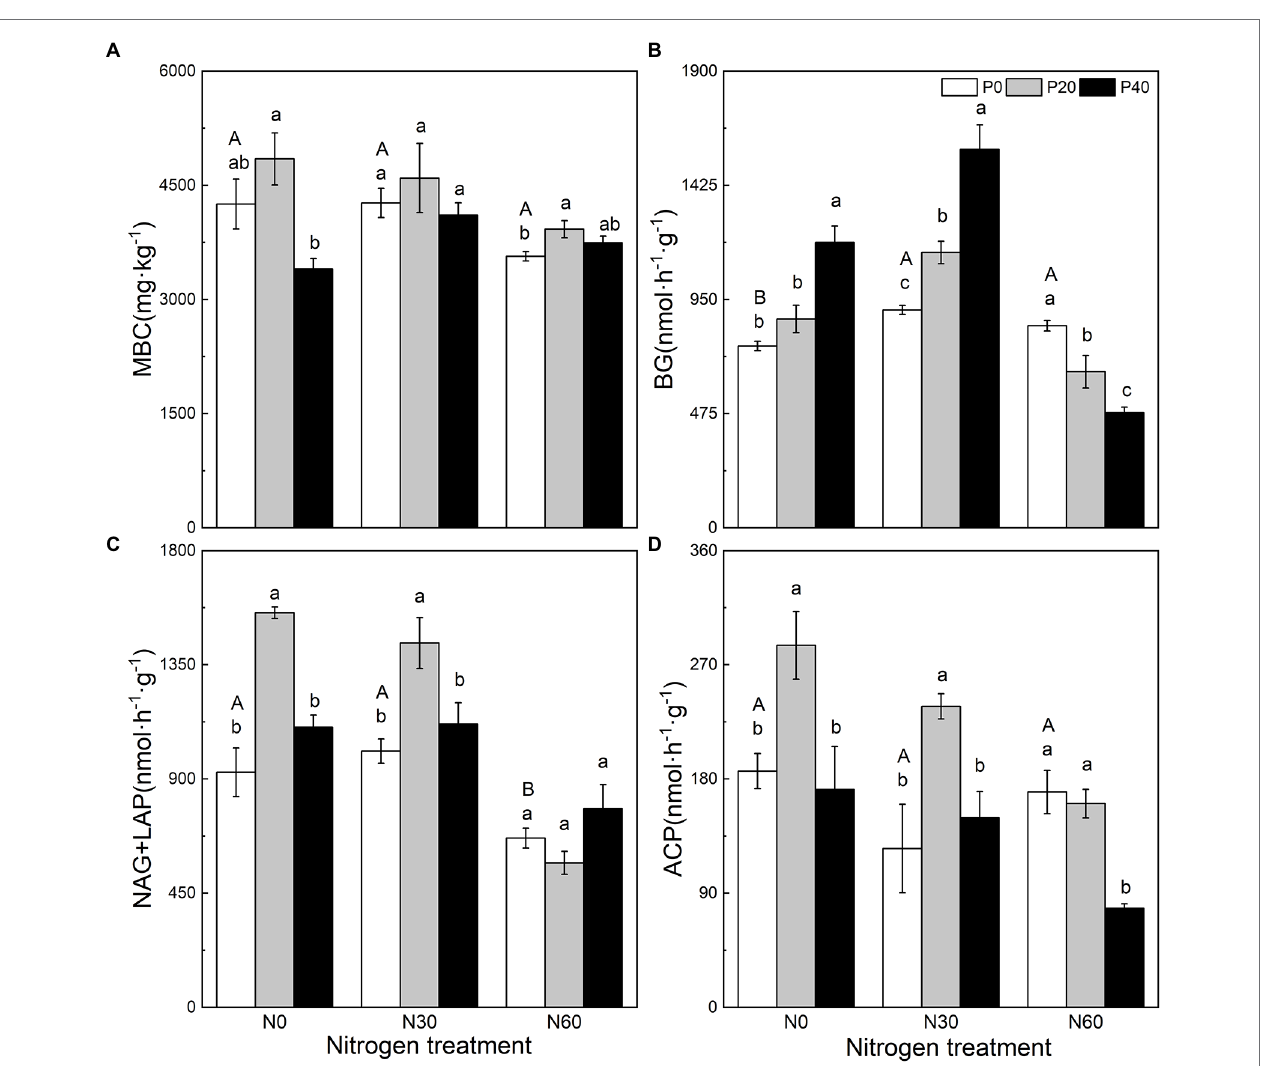
FIGURE 1 | The effect of simulated nitrogen (N) deposition and phosphorus (P) addition on microbial carbon content and soil enzyme activity. (A) Soil microbial biomass carbon. (B) The activity of soil β -glucosidase. (C) The activity of soil N-acetyl- β -D-glucosidase and soil leucine aminopeptidase. (D) The activity of soil